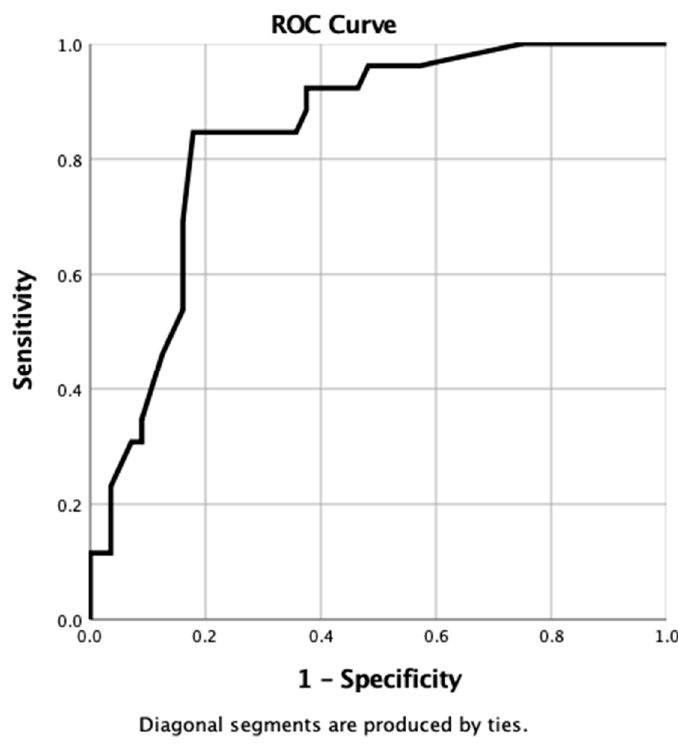
Figure 5. ROC curve generated from probabilities derived from IHC nomogram. When using the co-ordinates of this ROC curve, the optimal cut-off value of proba- bility to provide a binary predictor of tumour recurrence within 3 years was determined to be >90%. When this value was applied to all cases in the IHC dataset, the nomogram was found to have correctly identified 25 patients where recurrence occurred (true posi- tive) but incorrectly predicted recurrence in 31 patients when no recurrence was observed (false positive). The nomogram accurately predicted tumour-free survival in 25 patients (true negative) but failed to predict recurrence in 1 patient (false negative). Overall, the sensitivity, specificity, positive predictive, and negative predictive values of the IHC nom- ogram were 96%, 45%, 45%, and 96%, respectively. 3.5. Summary of Results When the predictive abilities of individual tumour characteristics were compared with the results of both the clinical and IHC nomogram, the IHC nomogram showed clear superiority in providing a reliable prediction of outcomes, with an AUC of 0.84 (Table 5). Table 5. Comparison of predictive abilities of individual tumour characteristics were compared with the results of both the clinical and IHC nomograms. C-Index AUC of ROC Curve (95% CI)